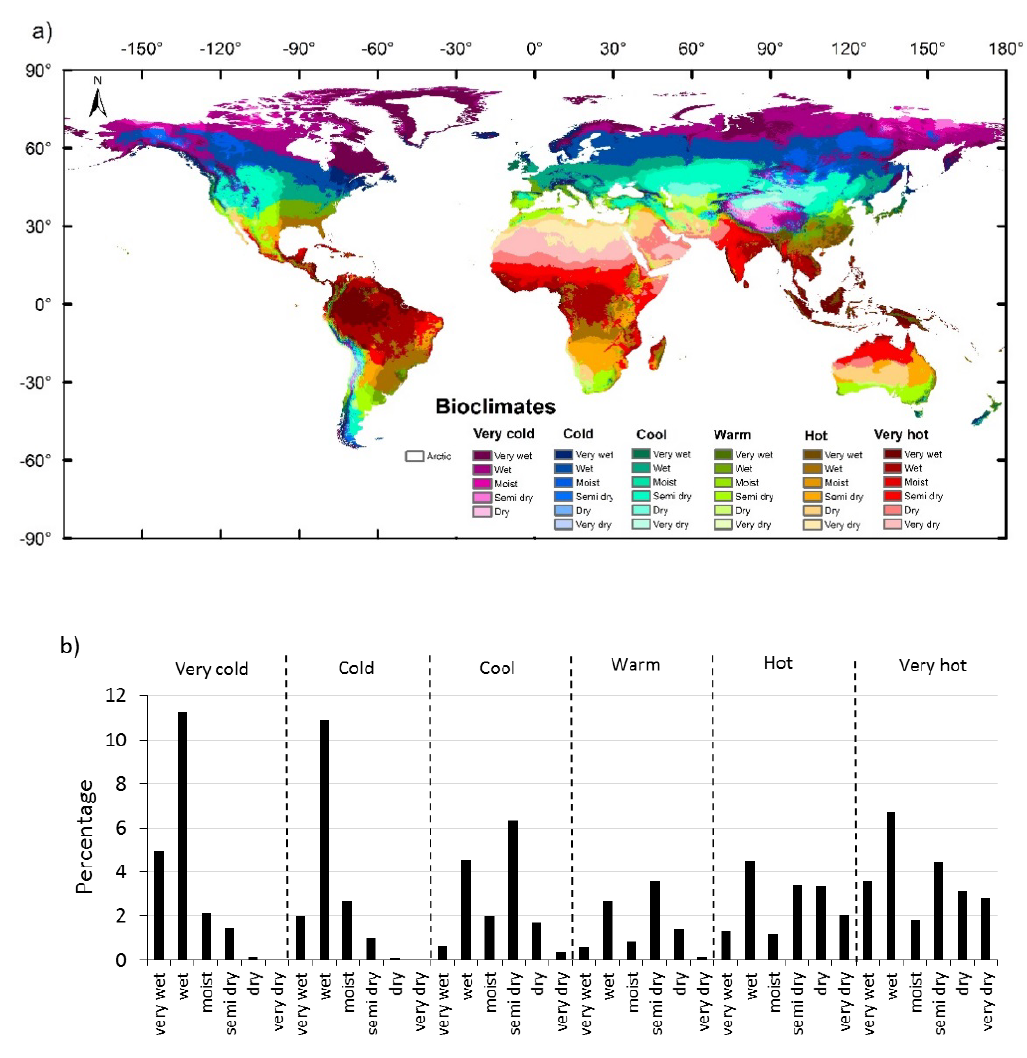
Figure 1. ( a ) Bioclimates derived from the global ecological land units map [68]. The lighter and darker colors indicate drier and more humid bioclimates respectively. ( b ) The number of pixels in percentage per bioclimate.